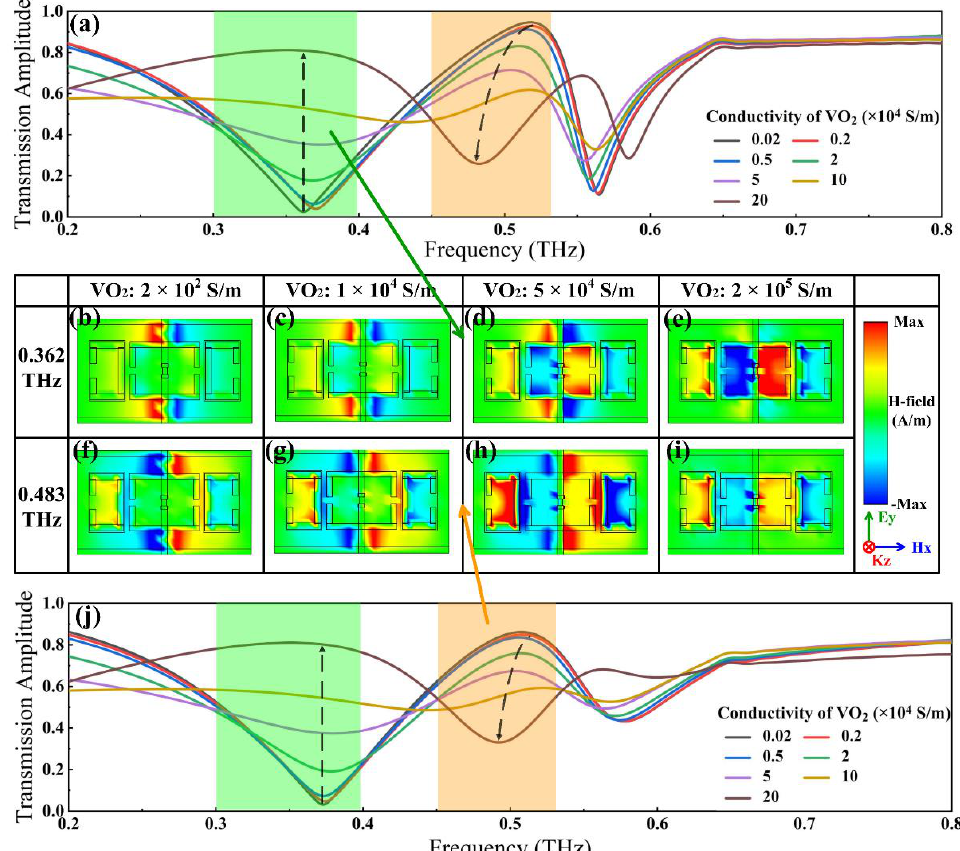
Figure 3. Characterizations of the hybrid metasurface modulated by the electrical method. Trans- mission spectra depending VO 2 bridge conductivity when the conductivity of the Ge layer was fixed at ( a ) 1 S/m and ( j ) 4 × 10 3 S/m. ( b – e ) Distributions of the H-field transmitted through the surface with the increase in VO 2 bridge conductivity at 0.362 THz when fixing Ge layers at 1 S/m. ( f – i ) Dis- tributions of the H-field transmitted through the surface with the increase in VO 2 bridge conductiv- ity at 0.362 THz when fixing Ge layers at 4 × 10 3 S/m.